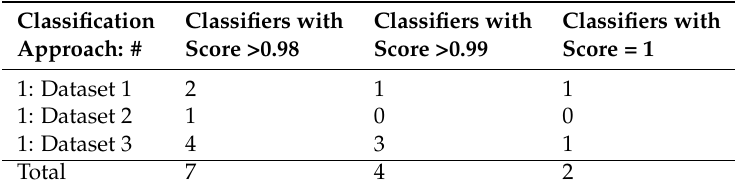
Table 6. Total Number of Machines According to the Score of Approach